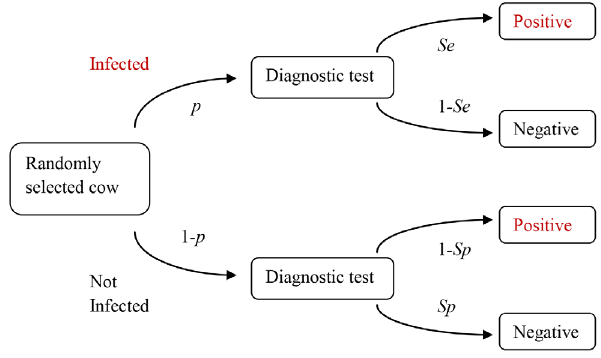
Figure 2. The four possible outcomes of testing a randomly selected animal for the presence of infection [ 21 ] . p =prevalence of infection in the herd, Se and Sp =sensitivity and specificity of the test, respectively. The positive predictive value (PPV) equals the probability of the animal being truly positive ( p * Se ) divided by the total probability of a positive test result (( p * Se ) + (1- p ) * (1- Sp )).